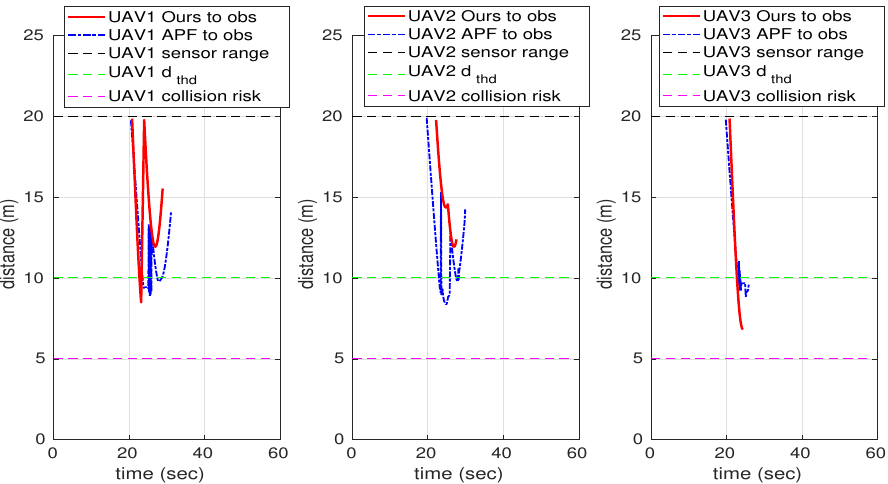
Figure 17. Relative distance to the nearest obstacle in the case of only dynamic obstacles. The last scenario is a complex case formed with two moving UAVs and multiple static obstacles. Although both approaches allow all UAVs to reach their goal positions without any collision, similar to case 4, only the proposed method plans optimal (i.e., shorter) and practicable smooth trajectories, shown in Figures 18 and 19. In fact, the proposed method’s UAV2 avoids dynamic (i.e., UAV1) and static obstacles safely during its mission while the proposed method’s UAV1 continues to go along its initially planned path without any collisions. In other words, Figures 18 and 20 show that the APF’s UAV1 has a longer history since it is hindered by UAV2. At similar times, the APF-based UAVs try to avoid each other, so their paths are not planned to be dynamically feasible (i.e., subfigures at the middle row of Figure